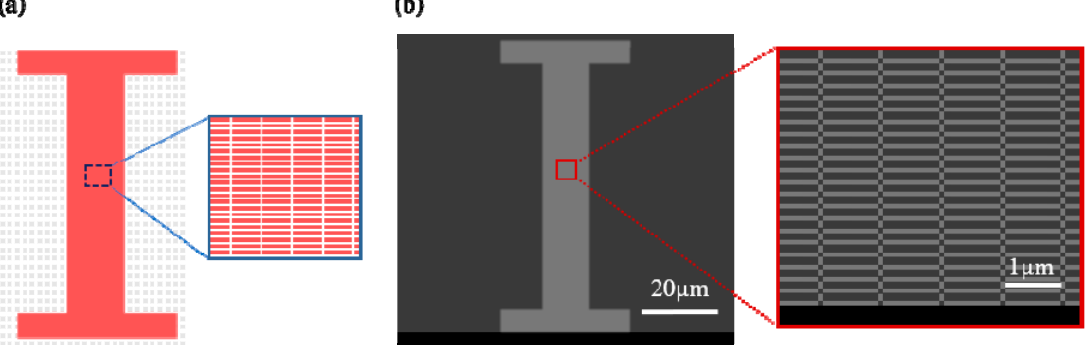
Figure 6. ( a ) Layout of rectangular graphene nanomesh (r-GNM) channel ( b ) SEM of rectangular graphene nanomesh (r-GNM)